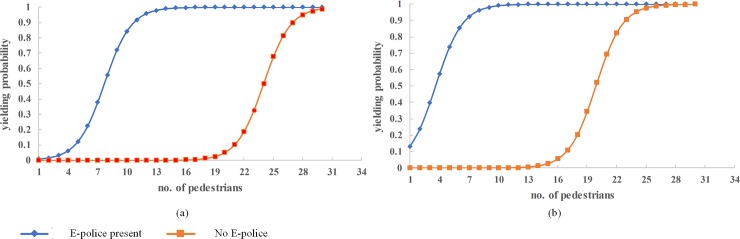
Effect of number of waiting pedestrians.